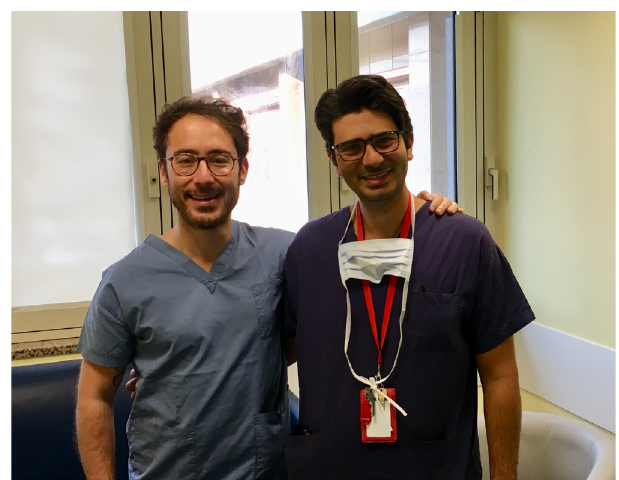
Fig. 1 - Ignazio Condello (on the left) and Giuseppe Santarpino (on the